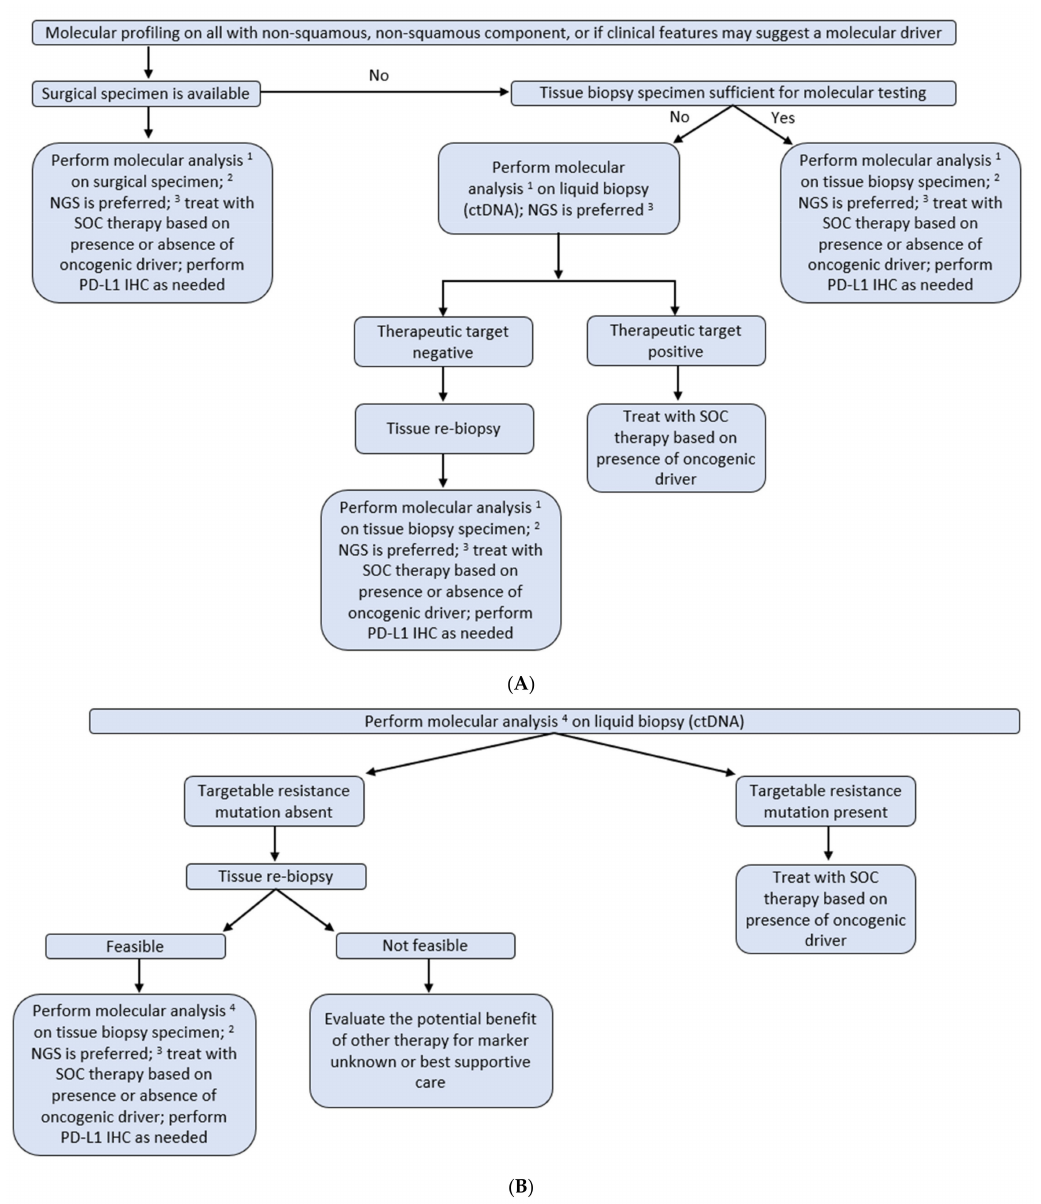
Figure 2. Liquid biopsy and tissue biopsy are complementary approaches for the molecular analysis of ( A ) patients with advanced, treatment-naïve NSCLC or ( B ) progressive or recurrent NSCLC during treatment with tyrosine kinase inhibitors. Reprinted from [42], J Thorac Oncol, Vol. 13, Rolfo, C., et al., Liquid biopsy for advanced non-small cell lung cancer (NSCLC): a statement paper from the IASLC, pages 1248–1268, Copyright (2018), with permission from the International Association for the Study of Lung Cancer. Published by Elsevier Inc. All rights reserved. Abbreviations: ALK , anaplastic lymphoma kinase; BRAF , B-Raf proto-oncogene; ctDNA, circulating tumour DNA; ddPCR, droplet digital polymerase chain reaction; EGFR , epidermal growth factor receptor; IHC, immunohistochemistry; NGS, next-generation sequencing; NSCLC, non-small cell lung cancer; PD-L1, programmed cell death ligand 1; ROS1 , ROS proto-oncogene 1; SOC, standard of care. 1 EGFR , ALK , ROS1 , and BRAF at minimum but a panel if available. 2 Strongly suggest tissue sparing to facilitate participation in clinical trials. 3 While NGS is preferred, based on availability, other validated assays are acceptable. 4 Cobas/ddPCR for EGFR mutation; NGS preferred for ALK and ROS1